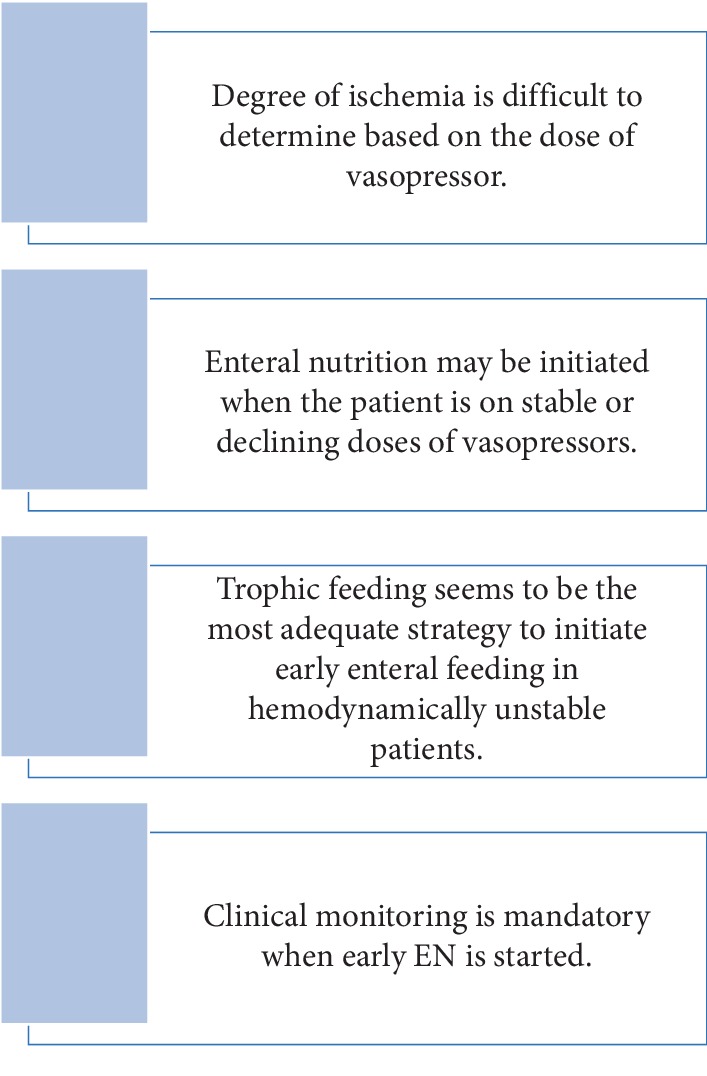
Take-home messages.